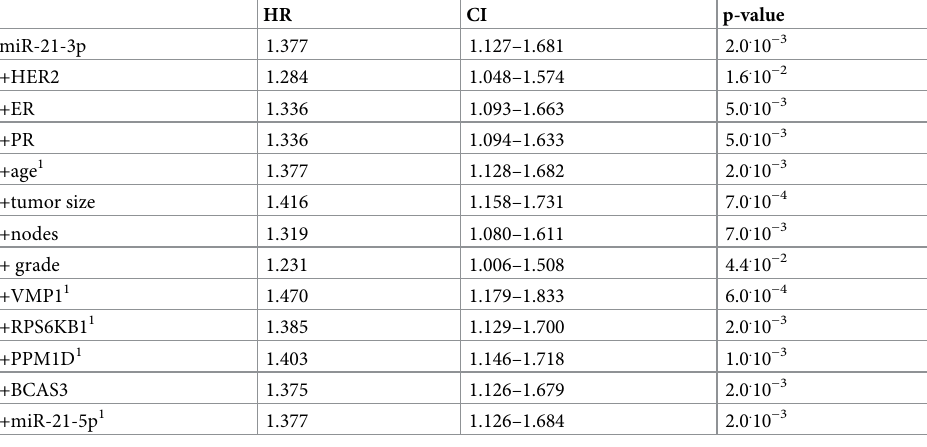
Table 1. Adjustment of BCSS in METABRIC (n = 1174) for confounding